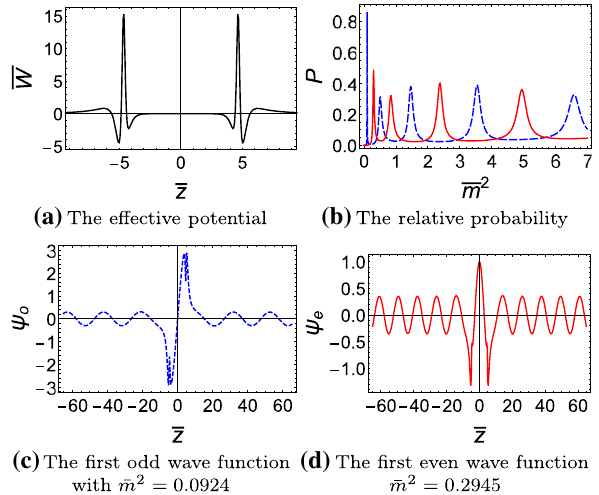
Fig. 11 The effective potential, the relative probability, and the wave functions of the first odd and even KK resonances with ¯ b = 10 and ¯ α = − 0 . 14 for case